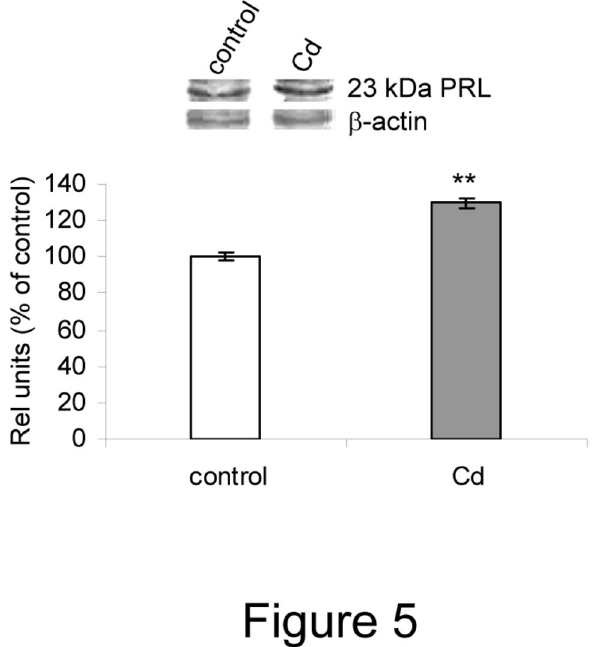
Figure 5. Cadmium increased 23 kDa prolactin (PRL) protein expression in anterior pituitary cells in culture. Anterior pituitary cells were incubated with 10 nM Cd or vehicle (control) for 8 h. Protein expression was measured by western blot. Bars represent mean ± SEM of PRL densitometric values normalized to β-actin and are expressed as percent of control. **P<0.01, Student’s ‘t’ test